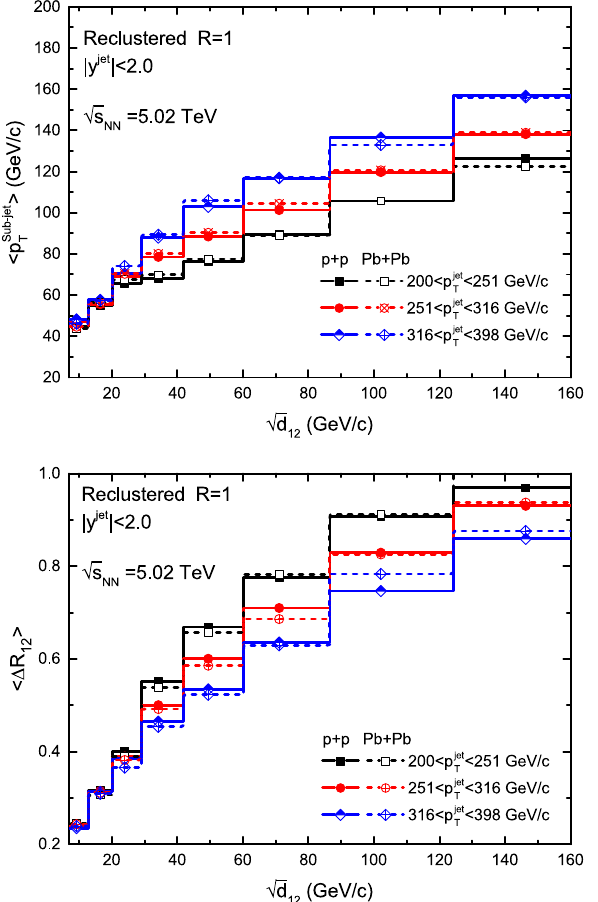
Fig. 8 Contributions from different processes to reclustered LR jet distributions as a function of the hardest jet splitting angle (cid:2) R 12 before jet quenching (BQ) and after jet quenching (AQ) respectively √ s NN = 5 . 02 TeV (top). Ratio of distributions from different pro- at cesses AQ to the distribution BQ (bottom). Detailed descriptions are in the